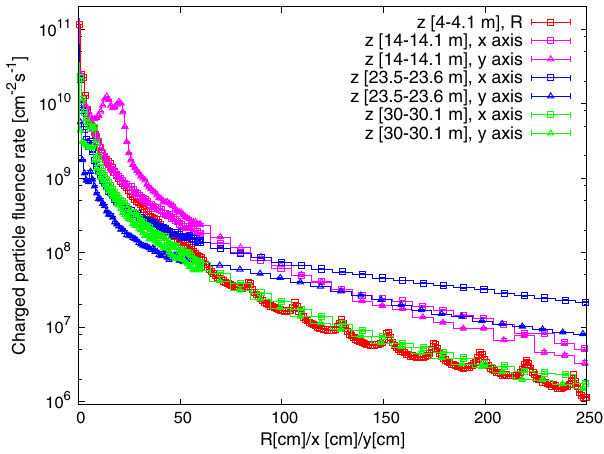
FIG. 7. Charged particle fluence rate for an instantaneous luminosity of 30 × 10 34 cm − 2 s − 1 as a function of the distance from the beam line, at different z positions in the detector. In the central region the values are averaged on the azimuthal angle Φ and they are shown as a function of the radius R, while in the forward region they are shown as a function of x and y separately. The values as a function of x ( y ) are obtained with an average in the vertical (horizontal) direction on a bin of 1 cm around y ¼ 0 ( x ¼ 0 ) up to x ð y Þ ¼ 0 . 6 m and on a bin of 10 cm for larger x ( y )